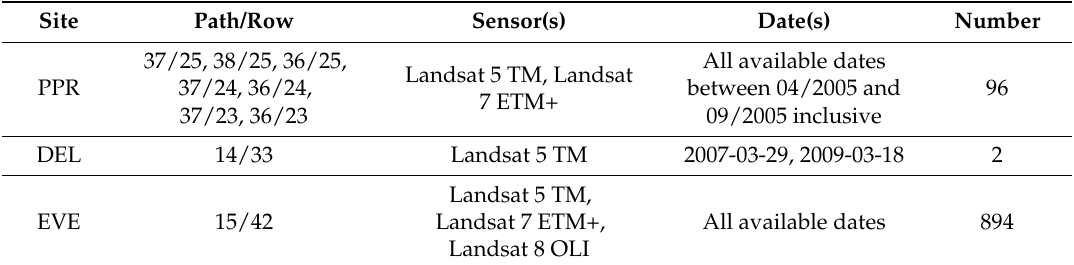
Table 1. Summary of Landsat data acquired over each of the three study sites (PPR, Prairie Pothole Region; DEL, Delmarva Peninsula; EVE, Everglades).